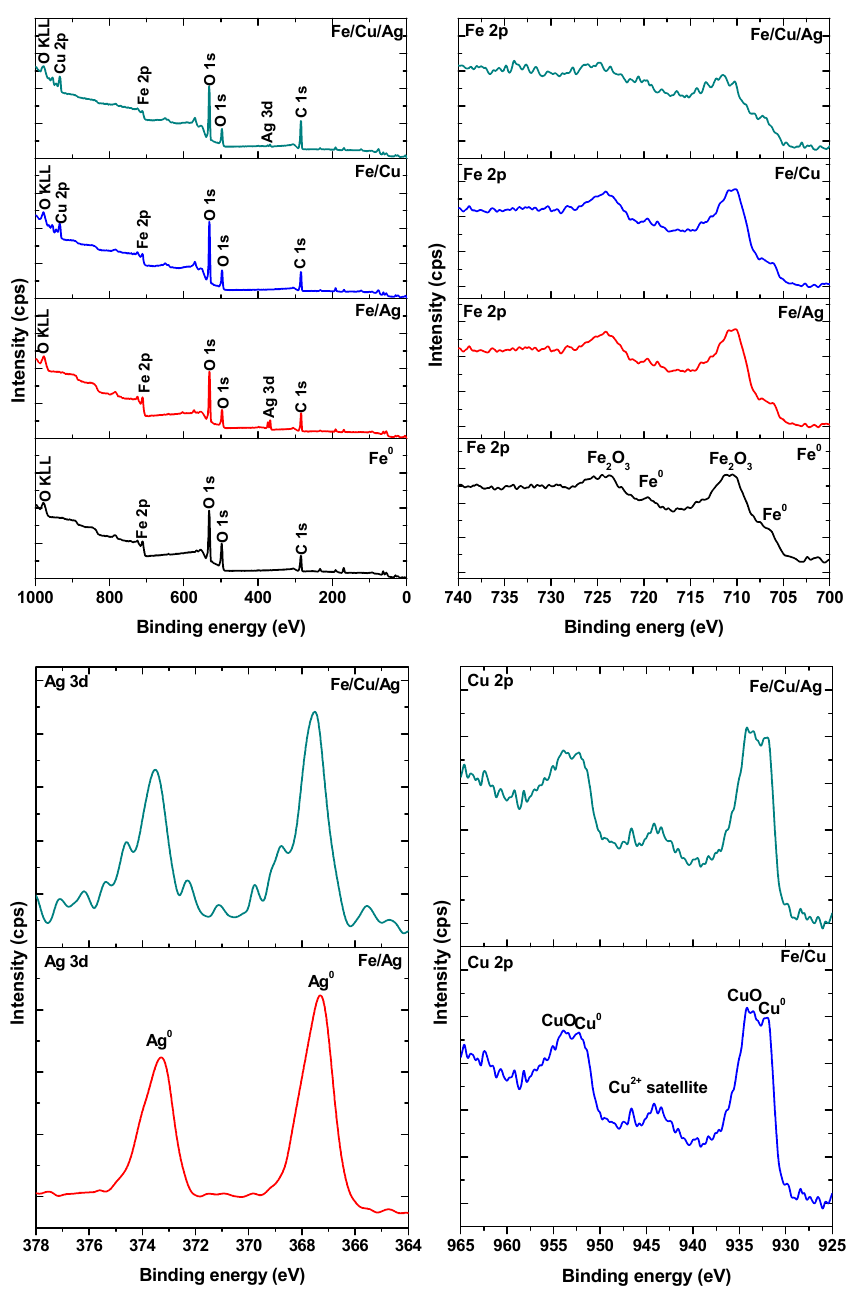
Figure 3. XPS survey spectra, Fe 2p, Ag 3d and Cu 2p high-resolution spectra of nZVI (Fe 0 ), Fe/Ag (5:0.1), Fe/Cu (5:1), and Fe/Cu/Ag (5:1:0.2) nanoparticles.